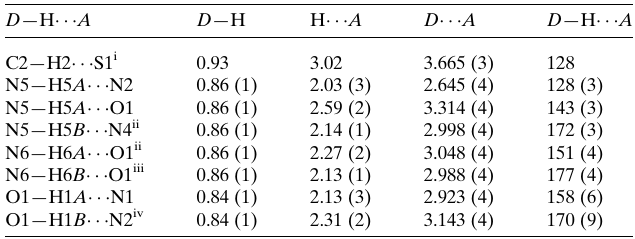
Table 1 Hydrogen-bond geometry (A˚ , (cid:3) ).